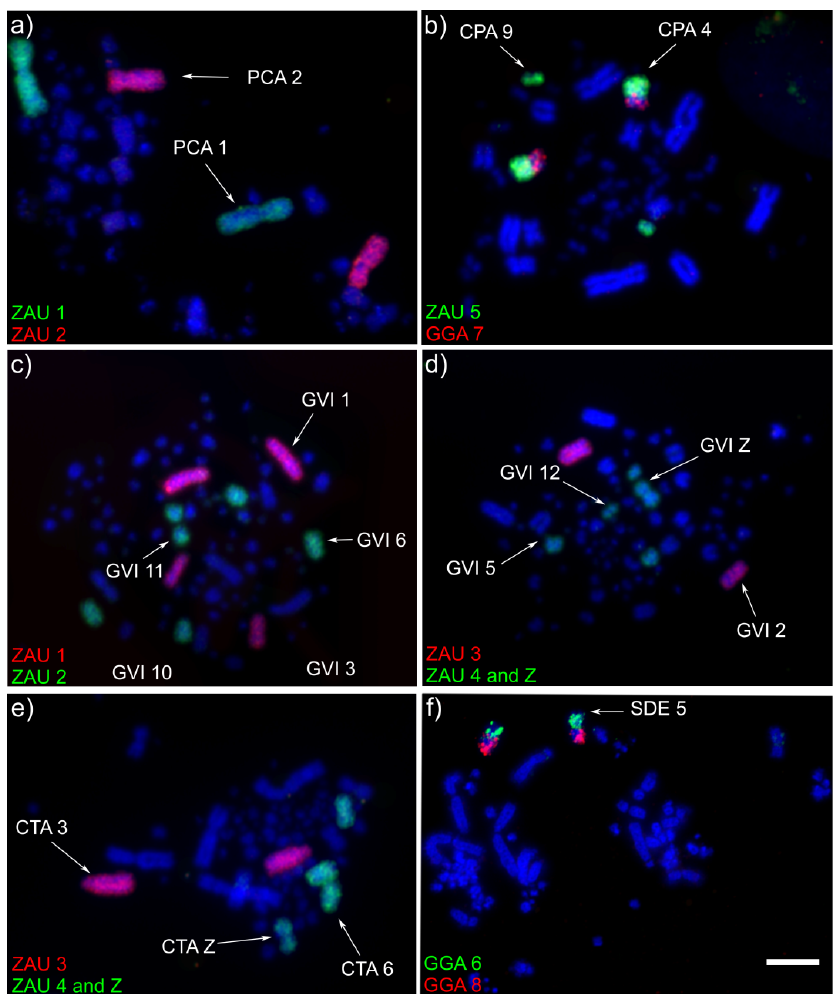
Figure 1. Representative FISH results using different sets of chromosome probes from Gallus gallus (GGA) and Zenaida auriculata (ZAU) probes on chromosomes of different Columbidae species: ( a ) Patagioenas cayennensis (PCA), ( b ) Columbina passerina (CPA), ( c ) Geotrygon violacea (GVI), ( d ) Geotrygon violacea (GVI), ( e ) Columbina talpacoti (CTA), ( f ) Streptopelia decaocto (SDE). The chromosome probes used are indicated on the left bottom, in green (fluoroscein labeled) or red (biotin ‐ cy3 labeled). Scale bar 10 μ m.